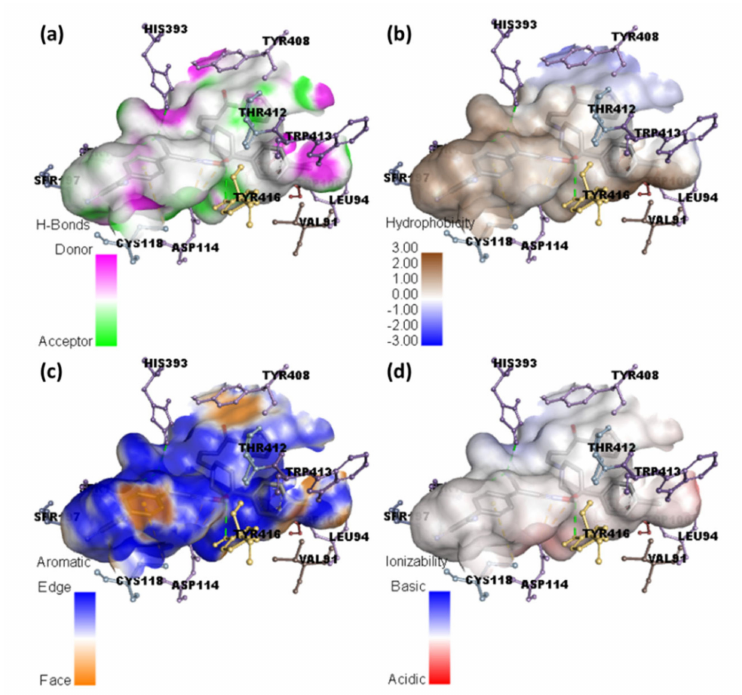
Figure 7. Representation of ( a ) hydrogen binding, ( b ) hydrophobic, ( c ) aromatic, and ( d ) ionizability surfaces between dopamine and CT complex.